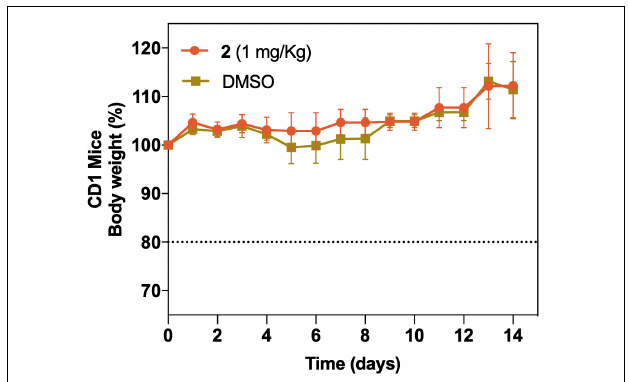
FIGURE 10 | In vivo acute toxicity of a single i.v. dose of 2 at 1 mg/kg ( n = 5) and vehicle control group (DMSO) ( n = 5). Body weight (as well as other visual toxicity signs) was monitored for 14 days posttreatment. The dotted line represents a 20% body weight loss, which was considered as an endpoint